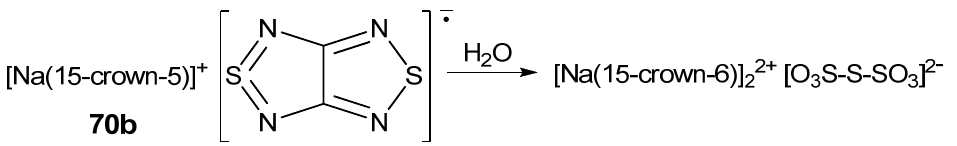
[S O ] obtained by hydrolysis of RA 2 3 6